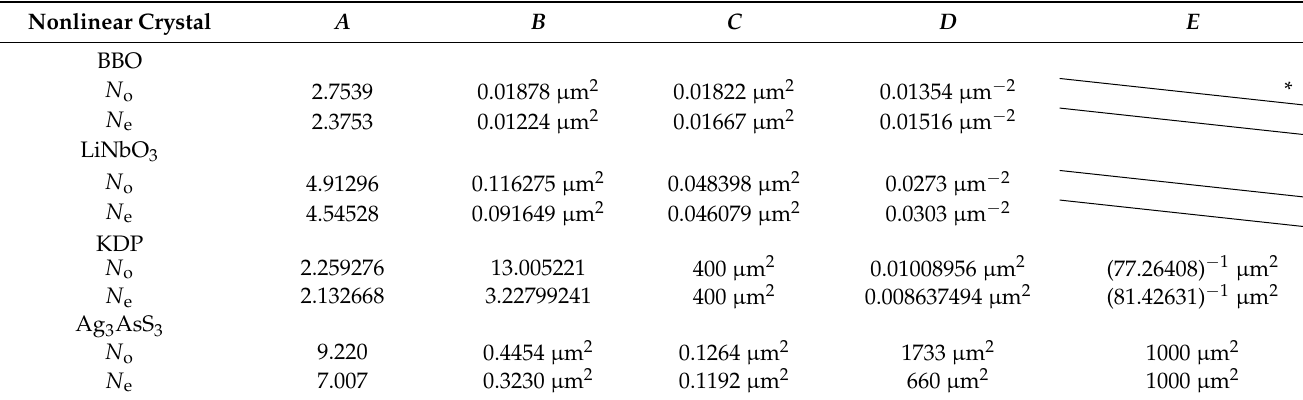
Table 1. The parameters of the Sellmeier equation for the calculation of refractive indices.